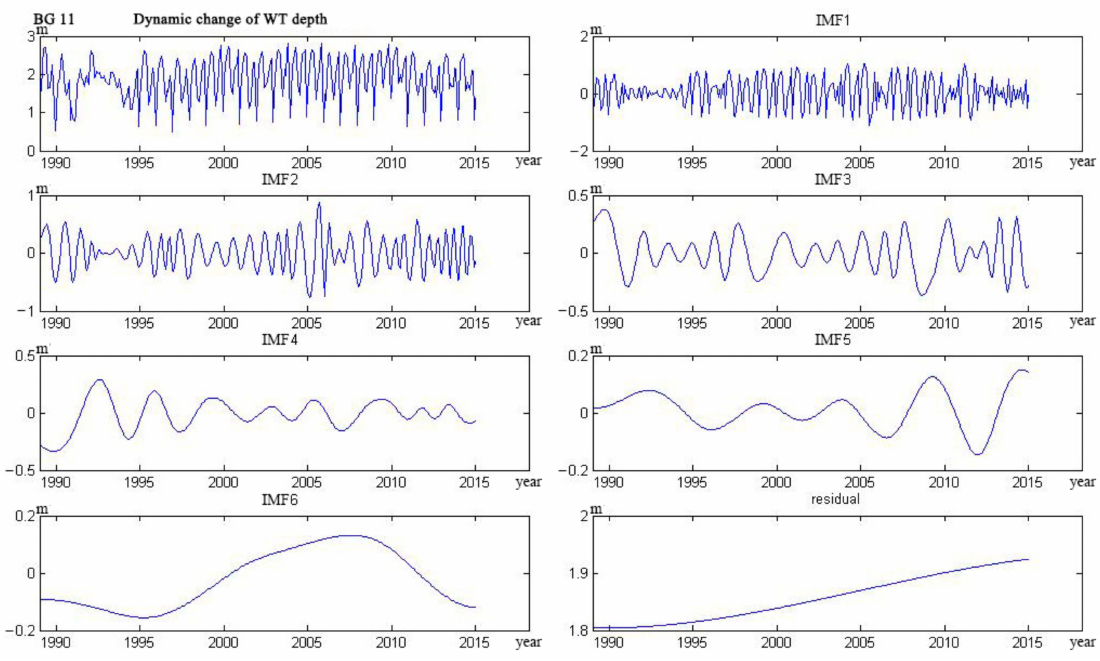
Figure A8. Decomposition of groundwater time series data of well